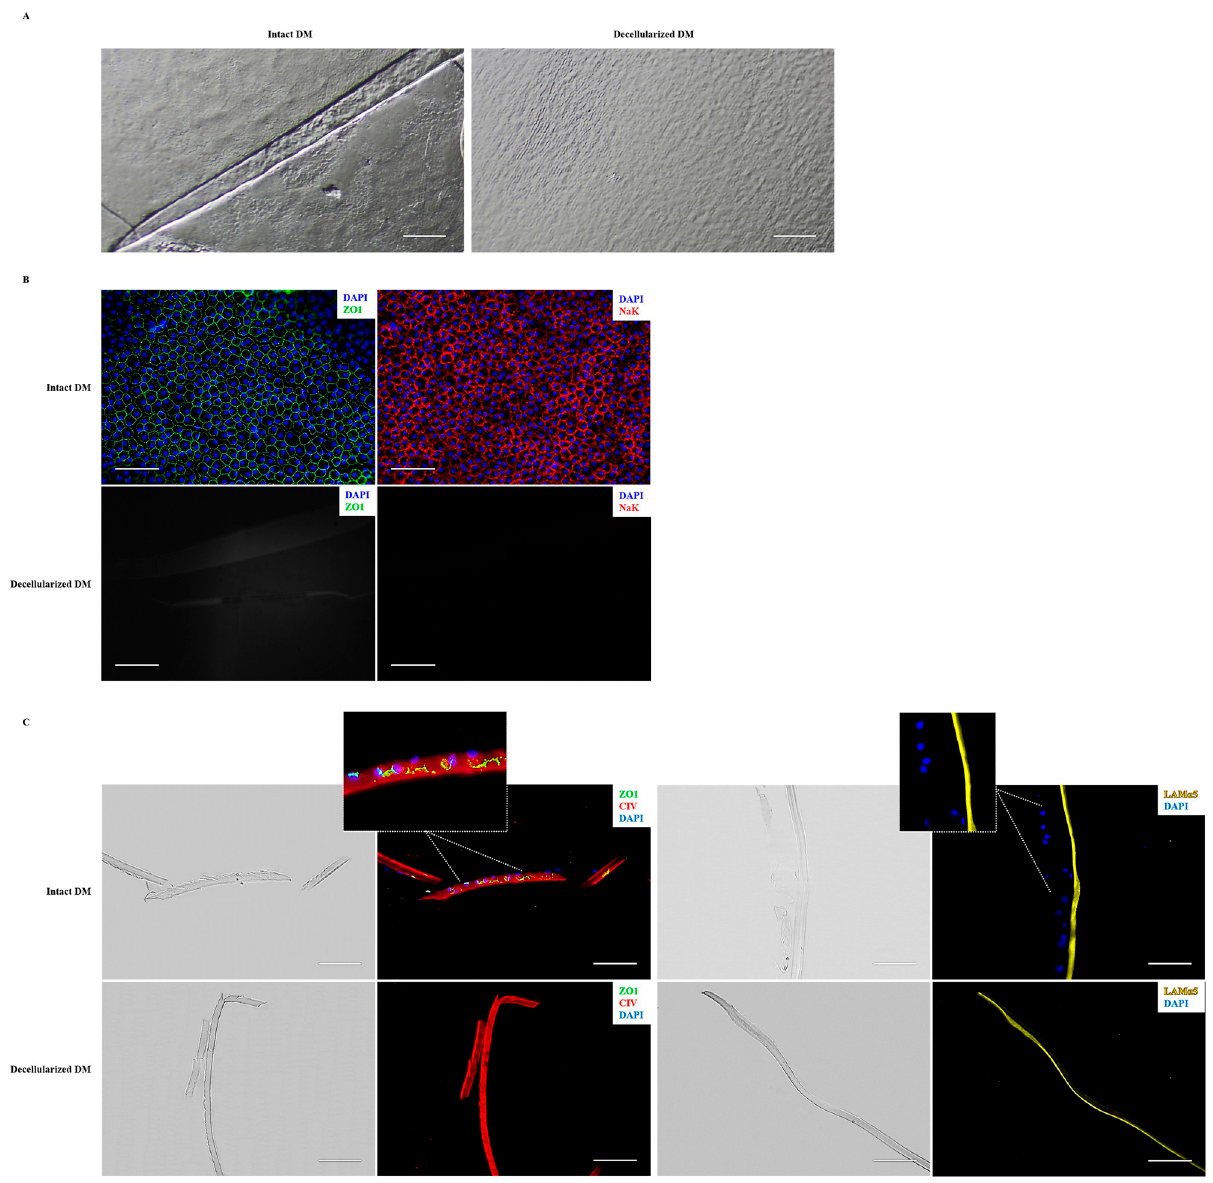
Fig 1. Assessment of Descemet’s Membrane denudation technique. ( A ) Representative stereoscopic microscope images of the DM before ( left panel ) and after ( right panel ) the decellularization process. ( B ) Immunofluorescence showing the expression of tight junction protein ZO1 ( left panels ; green ) and sodium-potassium pump NaK ( right panels ; red ) on DM before ( upper panels ) and after ( lower panels ) the decellularization process. ( C ) Immunostaining of ZO1 ( green ), type IV collagen ( red ) and Laminin α 5 ( yellow ) on DM cryosections before ( upper panels ) and after ( lower panels ) the decellularization process. The bright-field images show the entire intact ( upper panels ) and denuded ( lower panels ) tissues. Dotted rectangles indicate the regions that are magnified in the adjacent panels. All nuclei were stained with DAPI ( blue ). Scale bars = 100 μ m. DM, Descemet’s membrane; NaK, Na + /K +